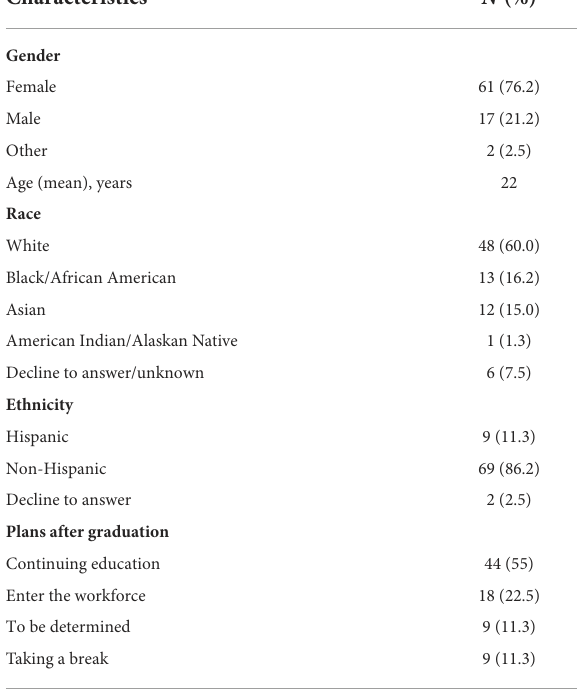
TABLE 1 Characteristics of graduating seniors of the BSPH program taking the capstone course in the spring 2022, N = 80.